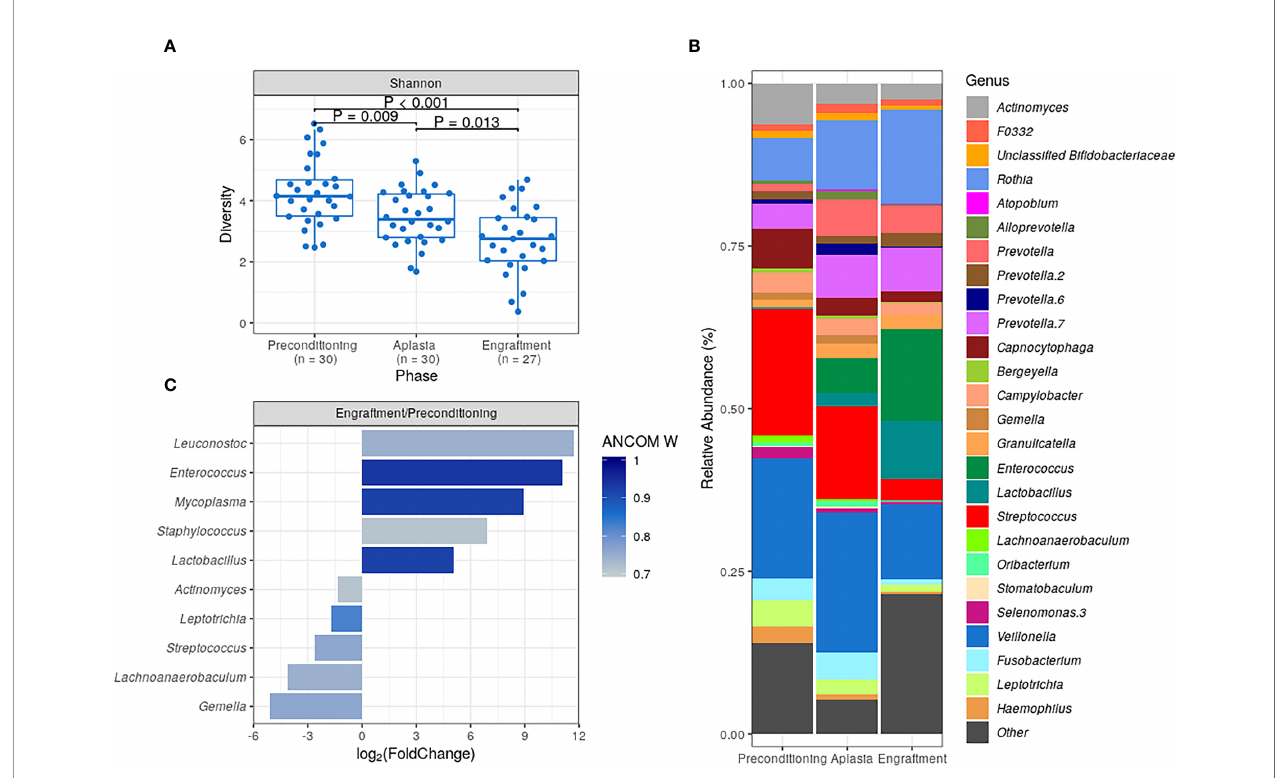
FIGURE 1 | Characterization of dental bio fi lm microbiota (DBM) during allogeneic hematopoietic stem cell transplantation. (A) DBM alpha diversity (Shannon) boxplots at preconditioning (n = 30), aplasia (n = 30) and engraftment (n = 27). Mann-Whitney U test was used with the preconditioning as the reference for comparisons. The boxes highlight the median value and cover the 25th and 75th percentiles, with whiskers extending to the more extreme value within 1.5 times the length of the box. (B) Average DBM genera relative abundance composition across transplantation phases. Only genera with at least 0.1% relative abundance in at least 25% study samples are shown. Taxa are sorted based on taxonomic relatedness. (C) Signi fi cant genera relative abundance variations from preconditioning to engraftment according to ANCOM test (W > 0.7). Log 2 (Fold Change) for the average relative abundance variation (Engraftment/Preconditioning) is